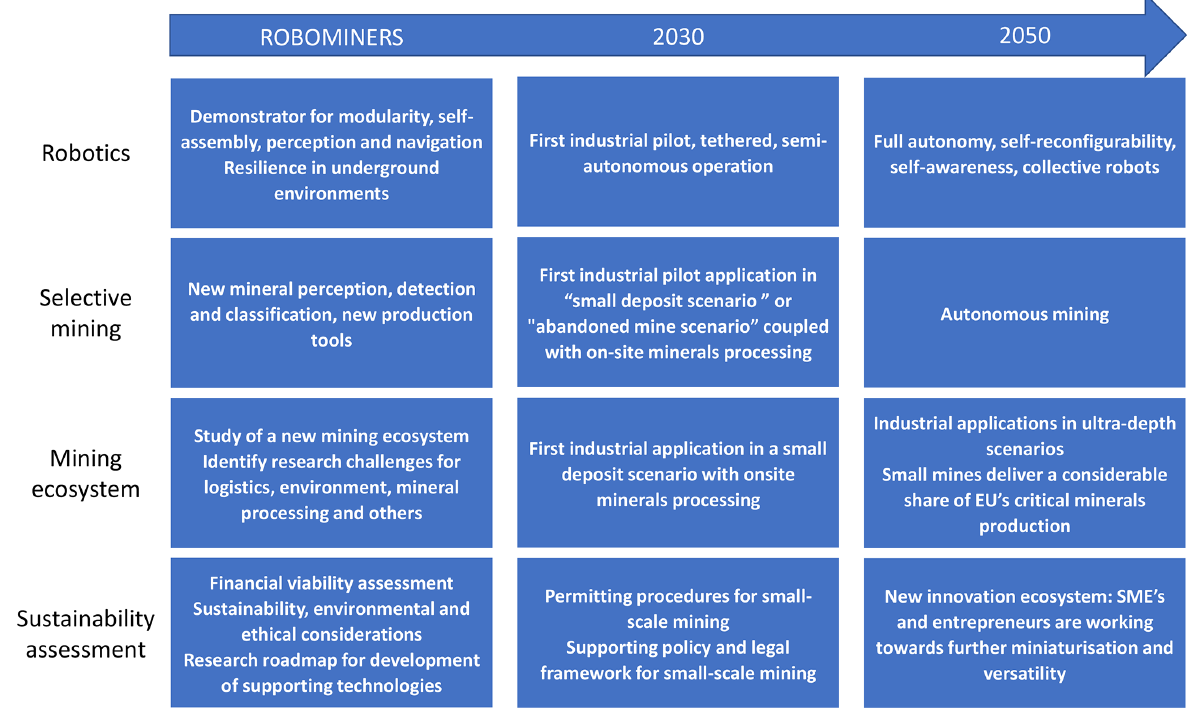
Figure 5. ROBOMINERS visions for the future on four different areas of